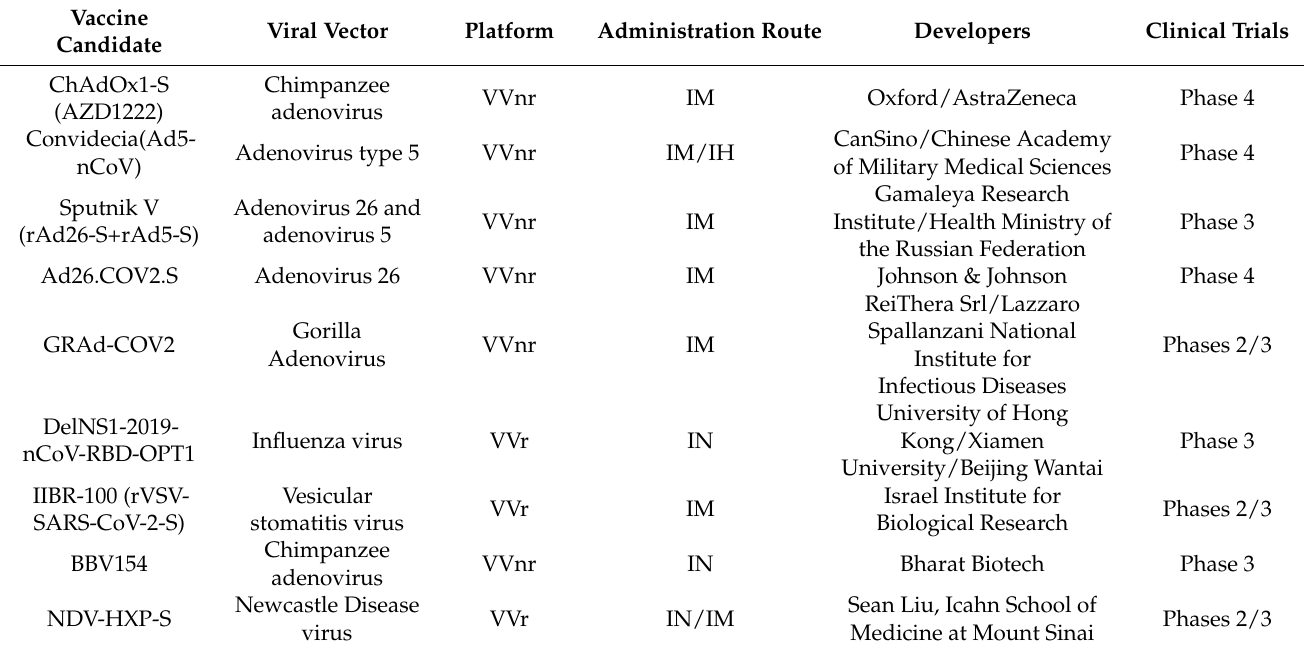
Table 2. Landscape of viral vector candidate vaccines in late clinical development for